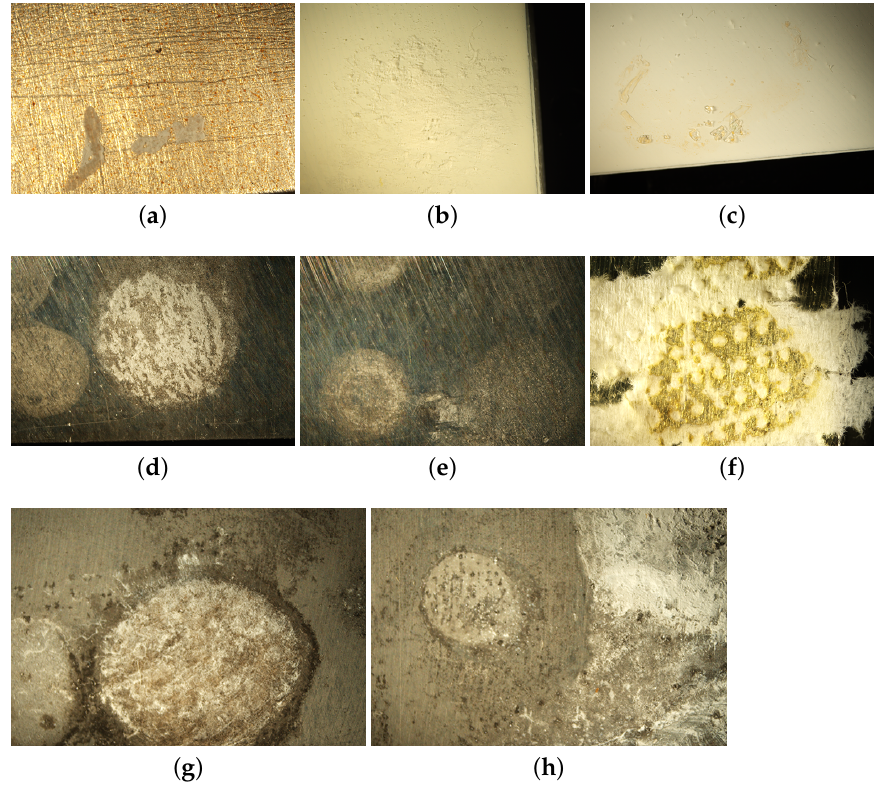
Figure 3. Optical Microscope images of selected samples at 6.5 × magnification. Salt residues deposed on transparent PA11 transparent coating ( a ) and on white GSF lacquer ( b , c ); damaged spots on transparent nanoceramic Easysol ( d , e ); damaged spots on transparent GSF lacquer ( f ); corrosion signs on the bare magnesium sample ( g , h